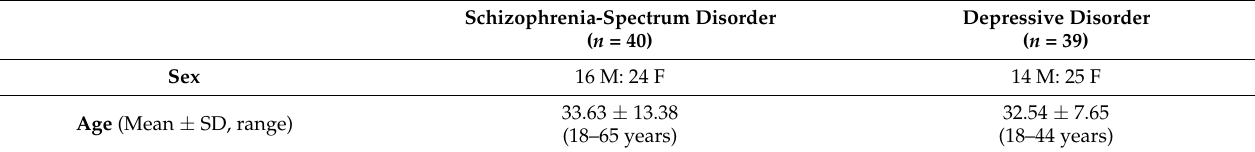
Table 2. Clinical data of patients with schizophrenia-spectrum disorder and depressive disorder.